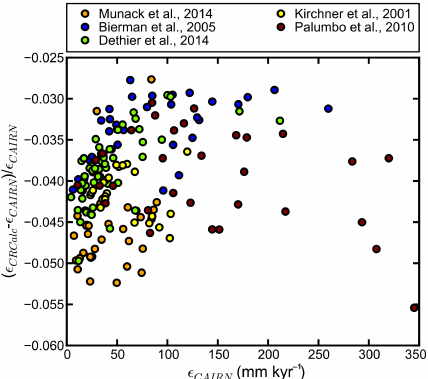
Figure 10. Differences between the denudation rate calculated by CAIRN ( (cid:15) CAIRN ) and the denudation rate calculated with CRONUScalc ( (cid:15) CRCalc ) as a function of CAIRN denudation rate for selected studies.